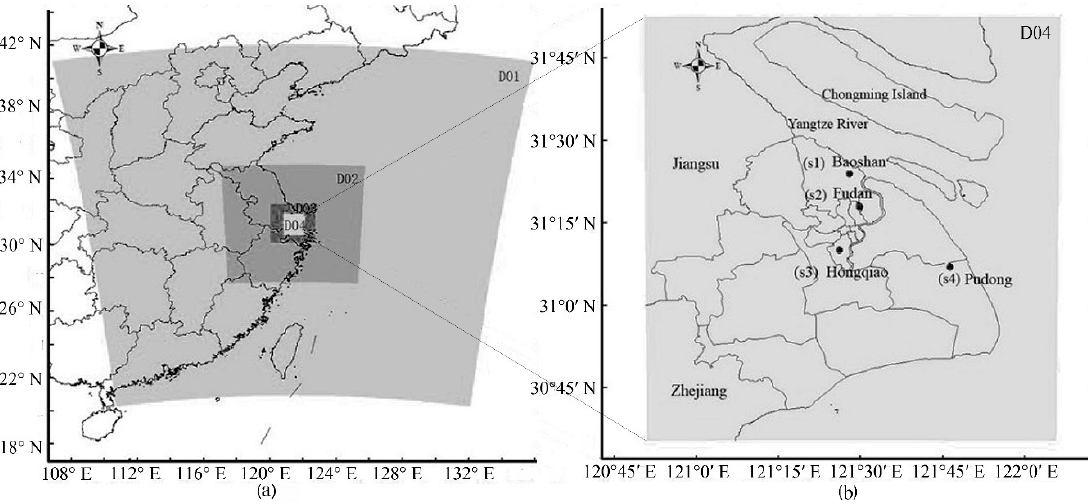
Figure 1. ( a ) Domain settings in the weather research and forecasting (WRF) model and ( b ) the measurement sites in measurement sites in Shanghai.